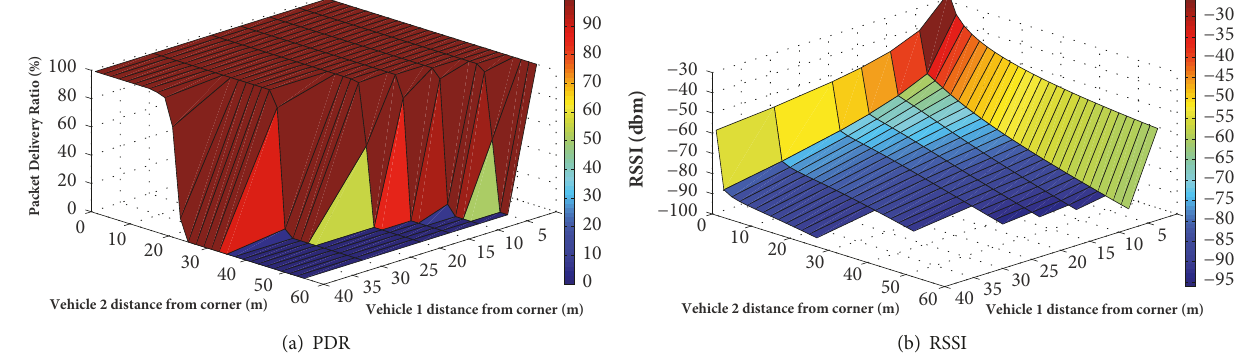
Figure 18: Results from the simulation when simulating with obstacle model. (a) PDR. (b)